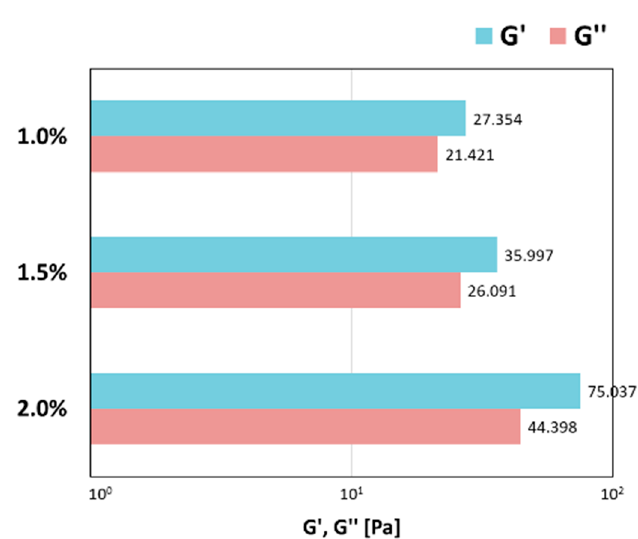
Figure 8. Values of the storage (G ′ ) and loss (G ″ ) moduli measured at a fixed oscillation frequency of 1 Hz for the samples prepared with A–C associations (ratio of 3:2) as a function of the total poly- mer amount (1%, 1.5%, and 2% w/w).